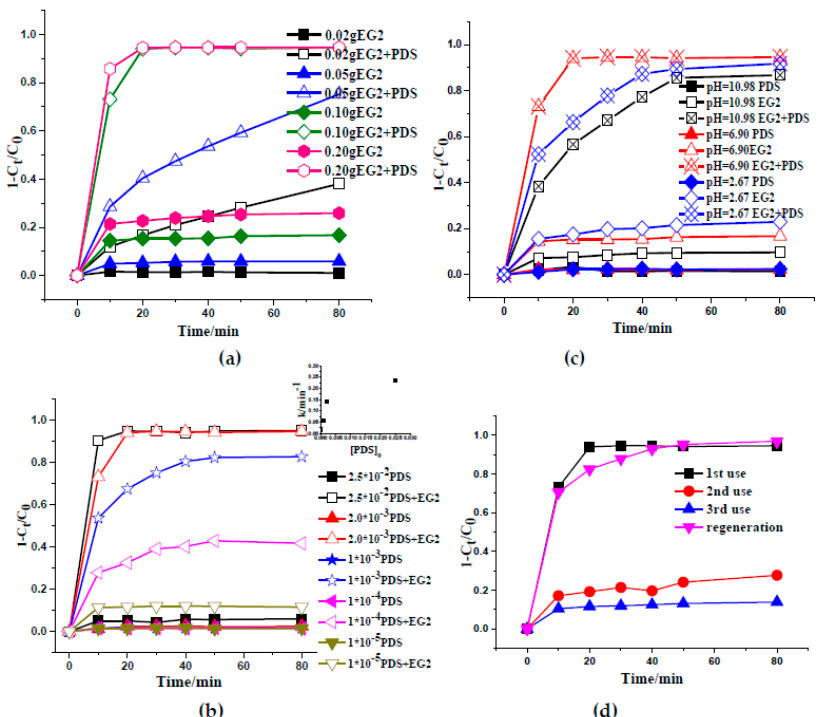
Figure 4. The effects of ( a ) catalyst dosage, ( b ) peroxydisulfate (PDS) dosage, ( c ) initial pH on AR97 removal, and ( d ) EG reuse in the EG/PDS combined system. [AR97] 0 = 50 mg × L − 1 ; [PDS] 0 = 2 mmol × L − 1 ; [EG2] 0 = 1 g × L − 1 ; pH = 6.9.